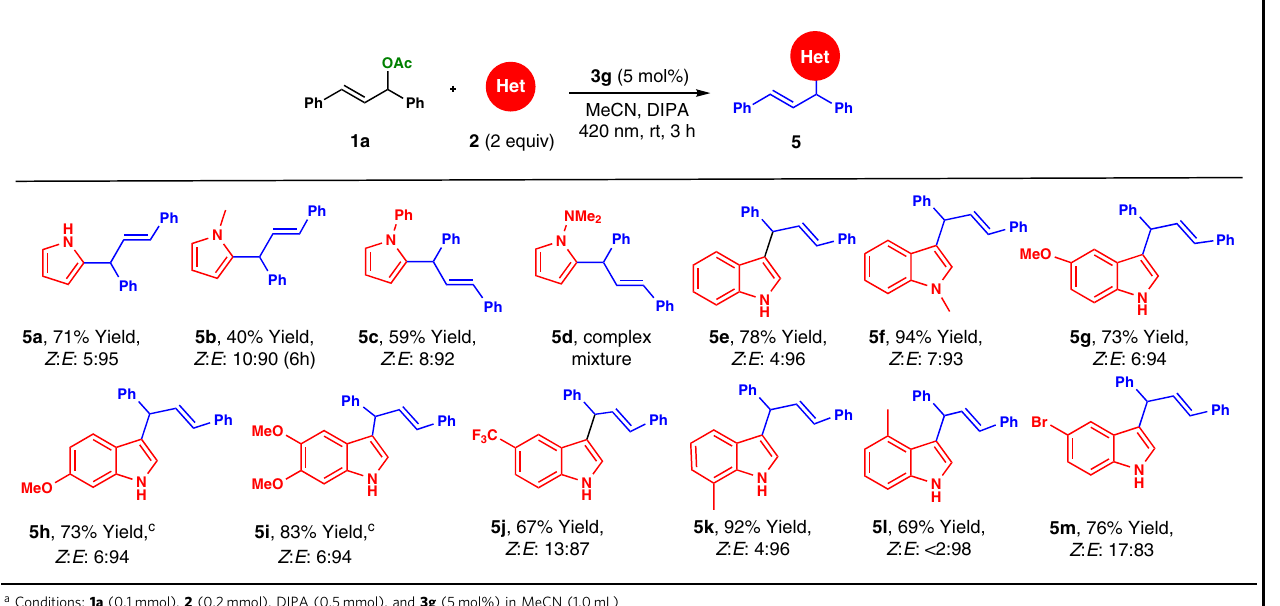
Table 3 Scope of the allylation reaction for the synthesis of E -isomers with pyrroles and indoles under catalyst 3g